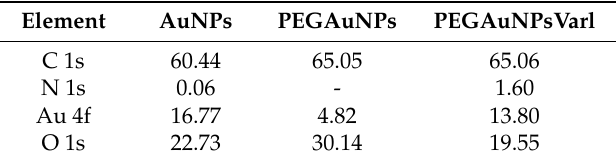
Table 2. XPS elemental composition of AuNPs, PEGAuNPS, and PEGAuNPsVarl (at % normalized to 100%). Element AuNPs PEGAuNPs PEGAuNPsVarl